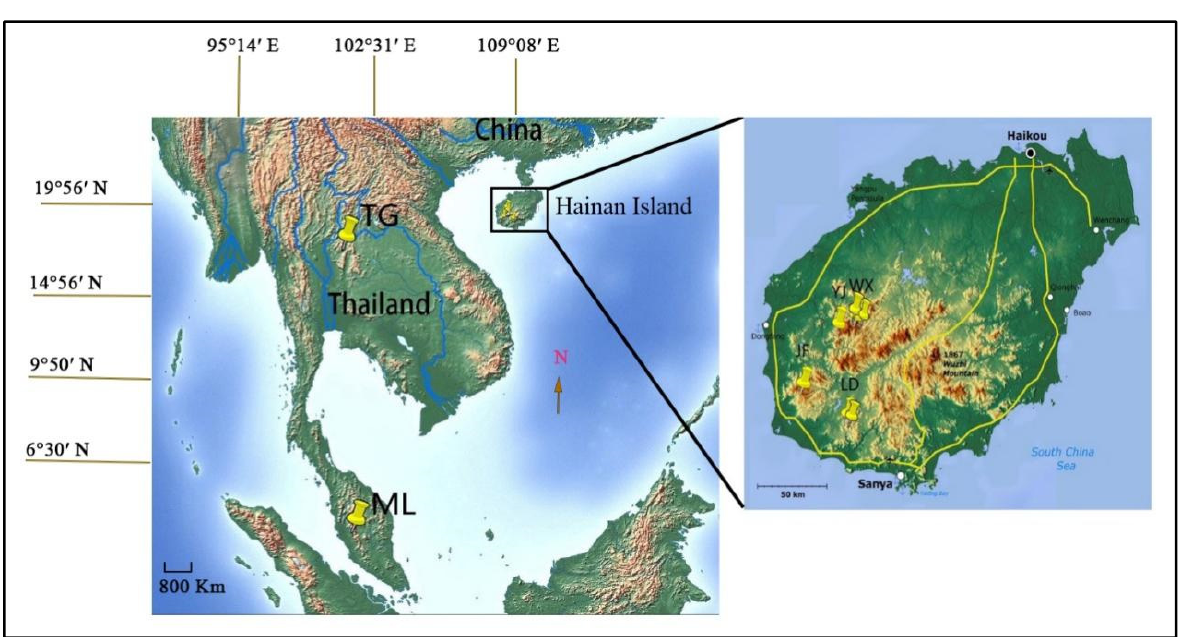
Figure 1. Sampled locations of 9 P. pulcherrima populations. Table 1. Locations, sample numbers, and altitudes of the sampled populations. Pop.